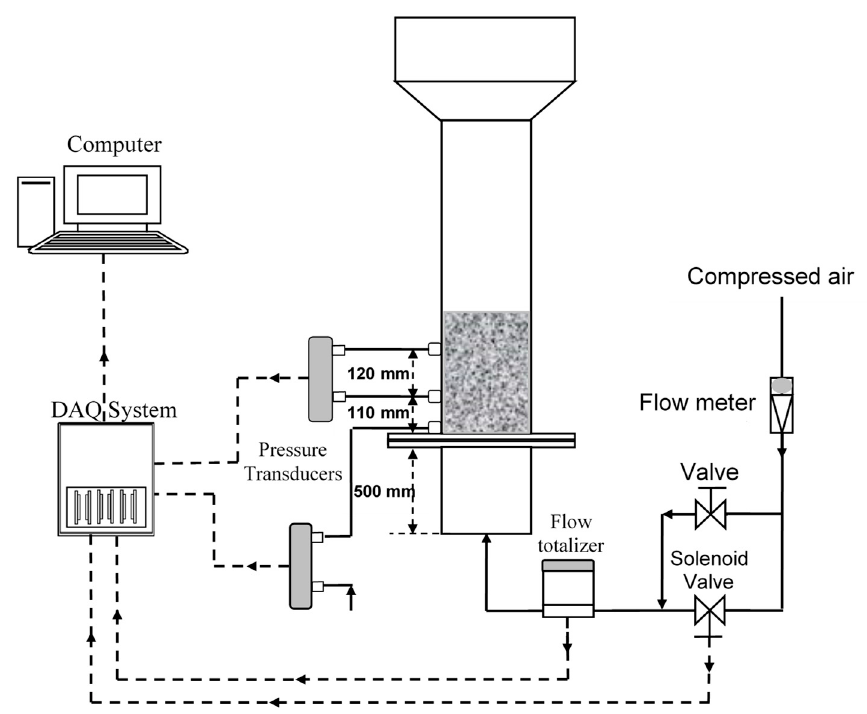
Figure 1. Schematic of the experimental setup . DAQ: data acquisition system.